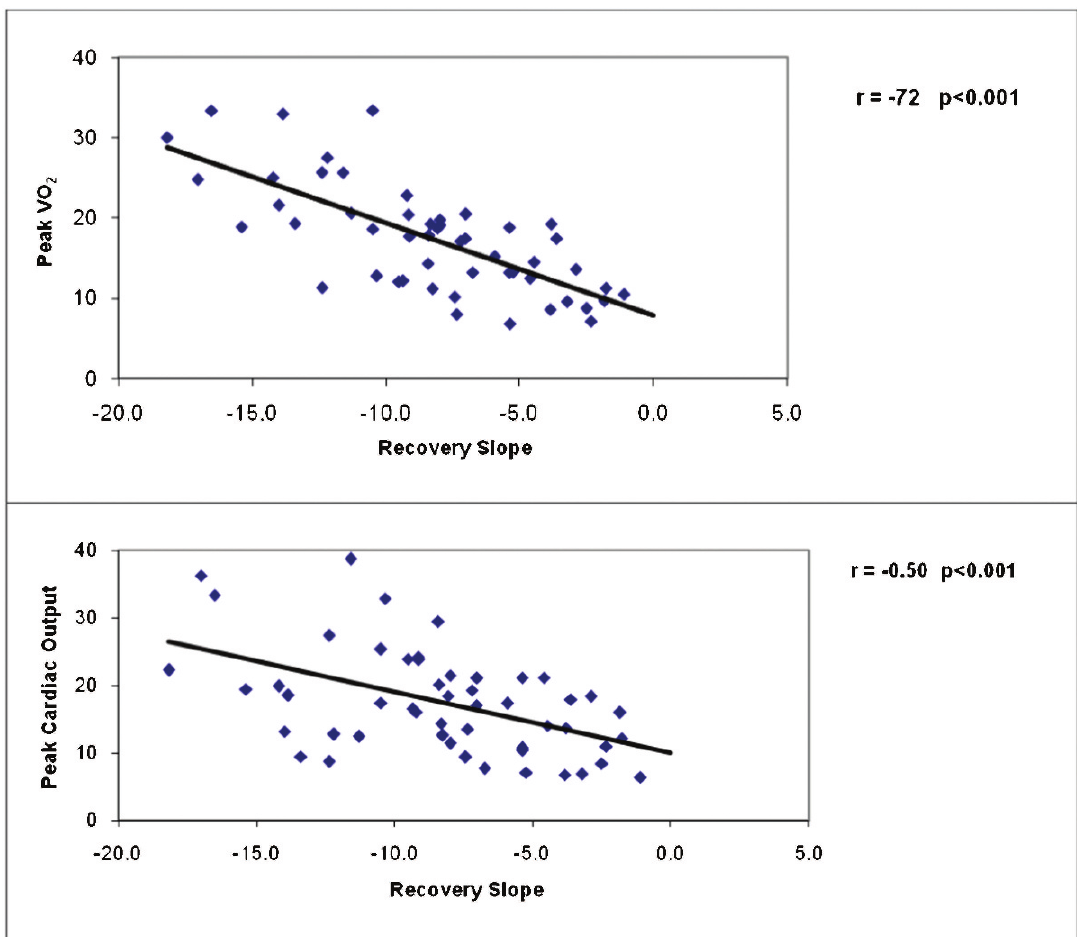
Figure 1 - The relationships between peak VO 2 , peak cardiac index, and cardiac output slope in